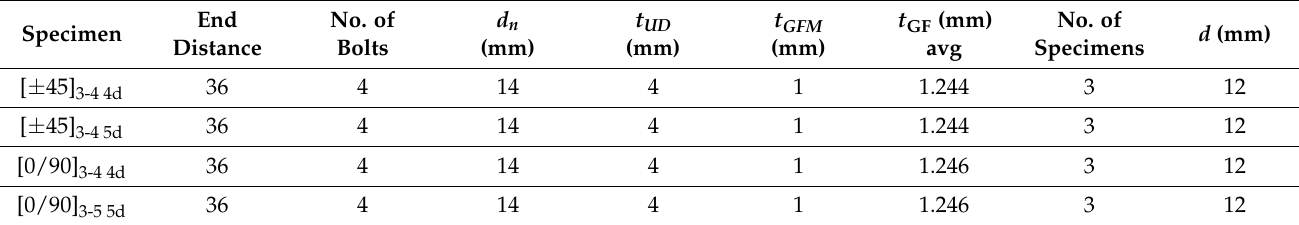
Table 3. Test program for PGFRP connections in GFS expansion.